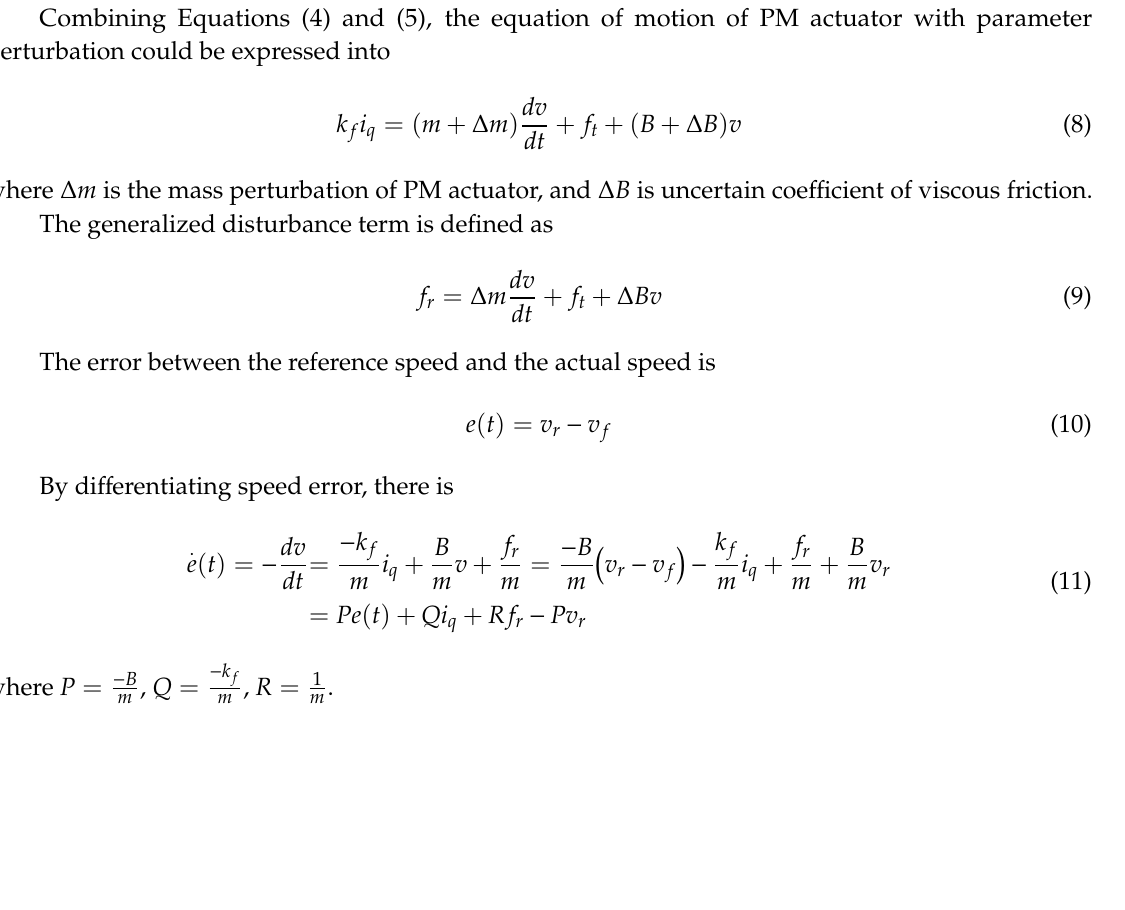
Figure 3. The sliding model control (SMC) model of segmented PMLSM.